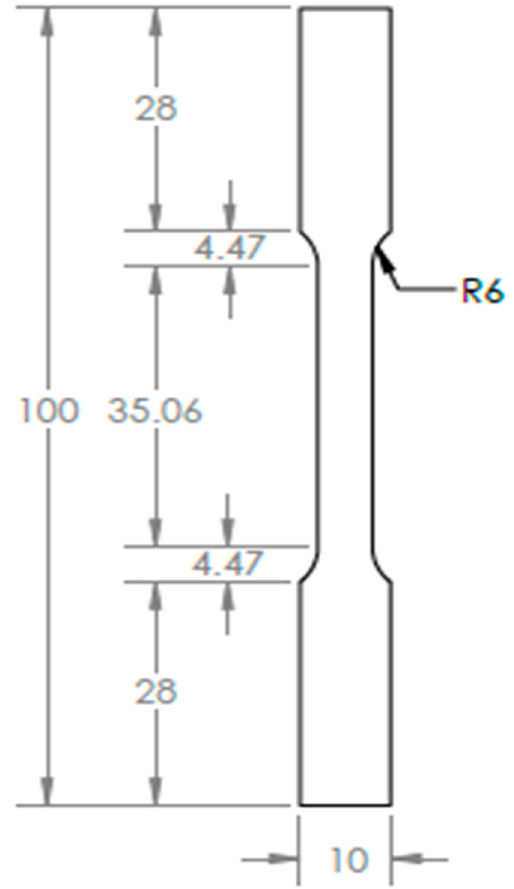
Figure 7. Tensile test specimen.